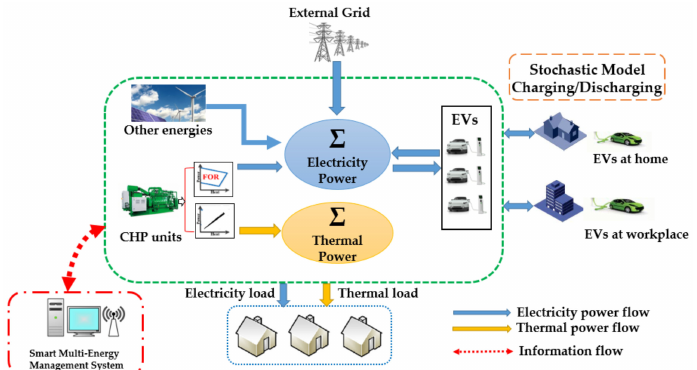
Figure 1. System architecture of a typical multi-energy system (MES). EVs: electric vehicles; CHP: combined heat and power.